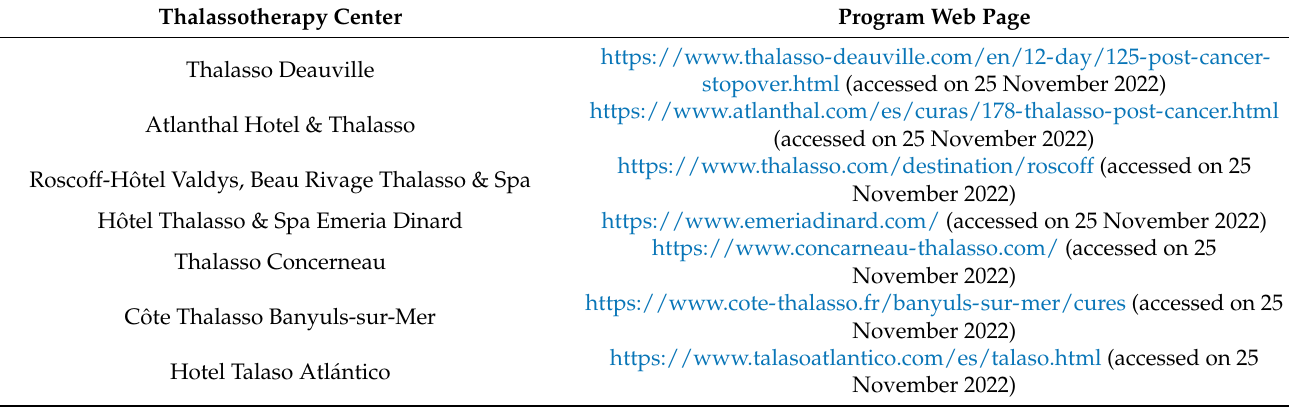
Table 3. Post-oncologic care programs in thalassotherapy